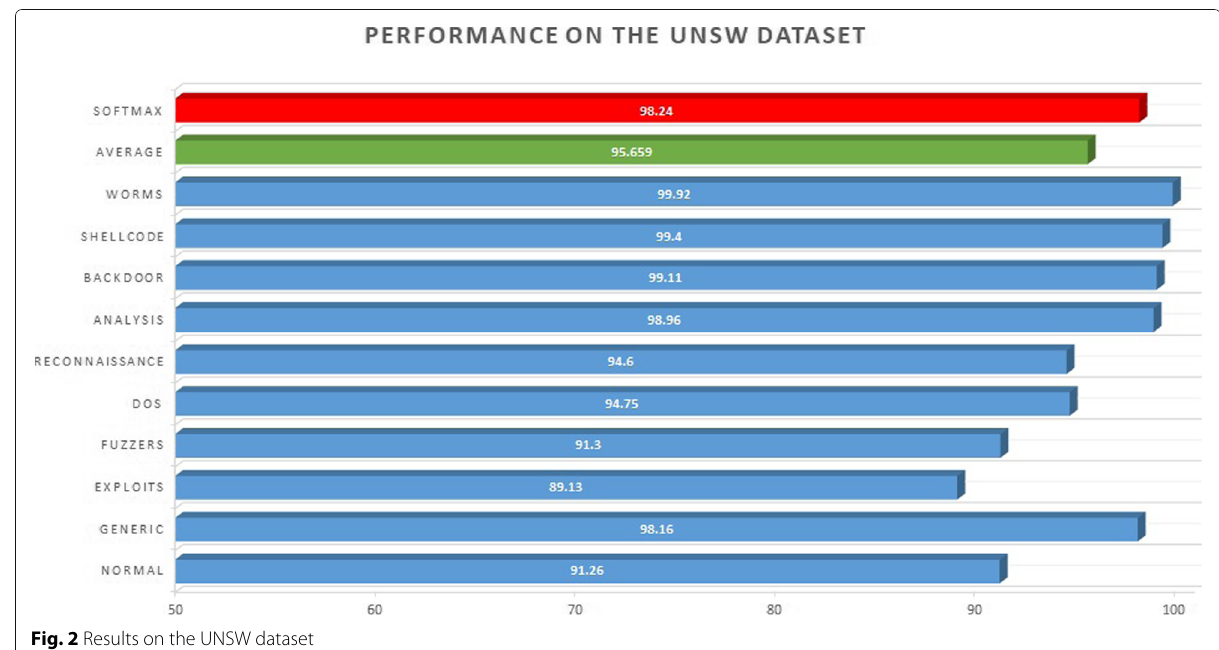
Fig. 2 Results on the UNSW dataset